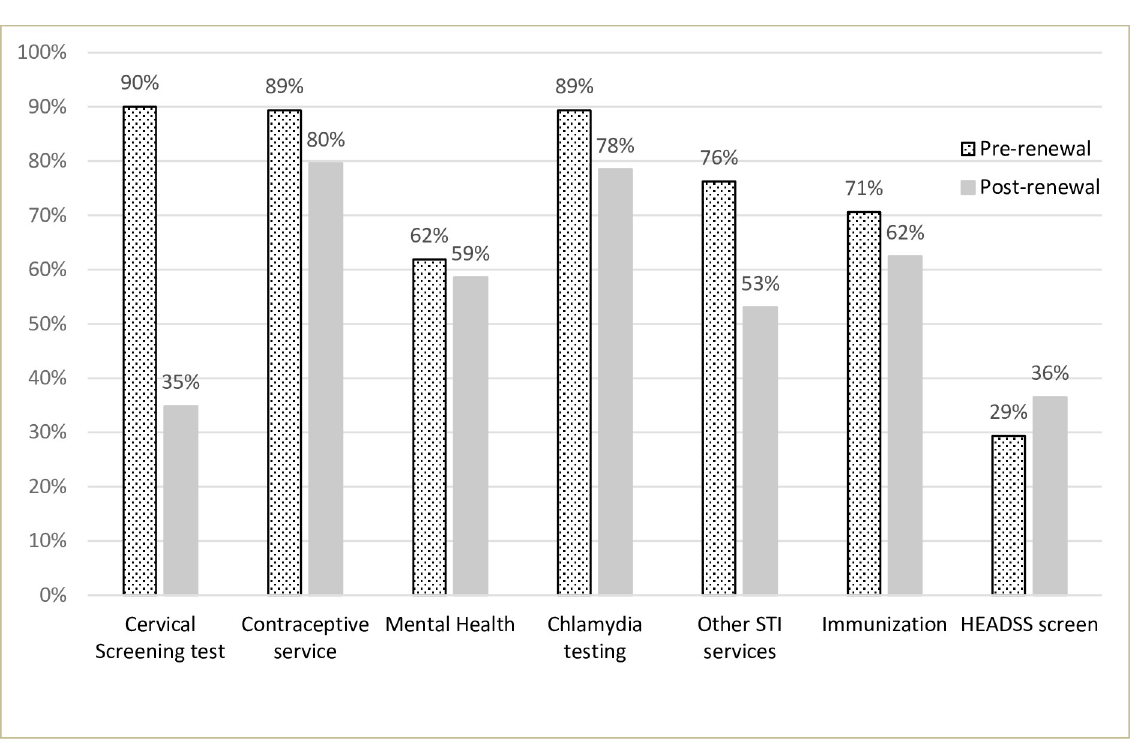
Fig 1. Self-reported offering of preventive services to asymptomatic sexually active females < 25 years in the pre- and post-renewal period samples by practitioners (n = 160 pre, n = 181 post). HEADSS is a risk assessment tool to assess psycho-social health of adolescents and stands for Home, Education/employment, peer group Activities, Drugs, Sexuality, and Suicide/depression. Cervical screening tests are no longer routinely recommended to women < 25 years in the post-renewal period with the exception of those in follow-up and some selected women (e.g.